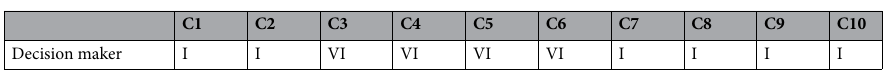
Table 3. Importance of criteria according to the decision-maker.